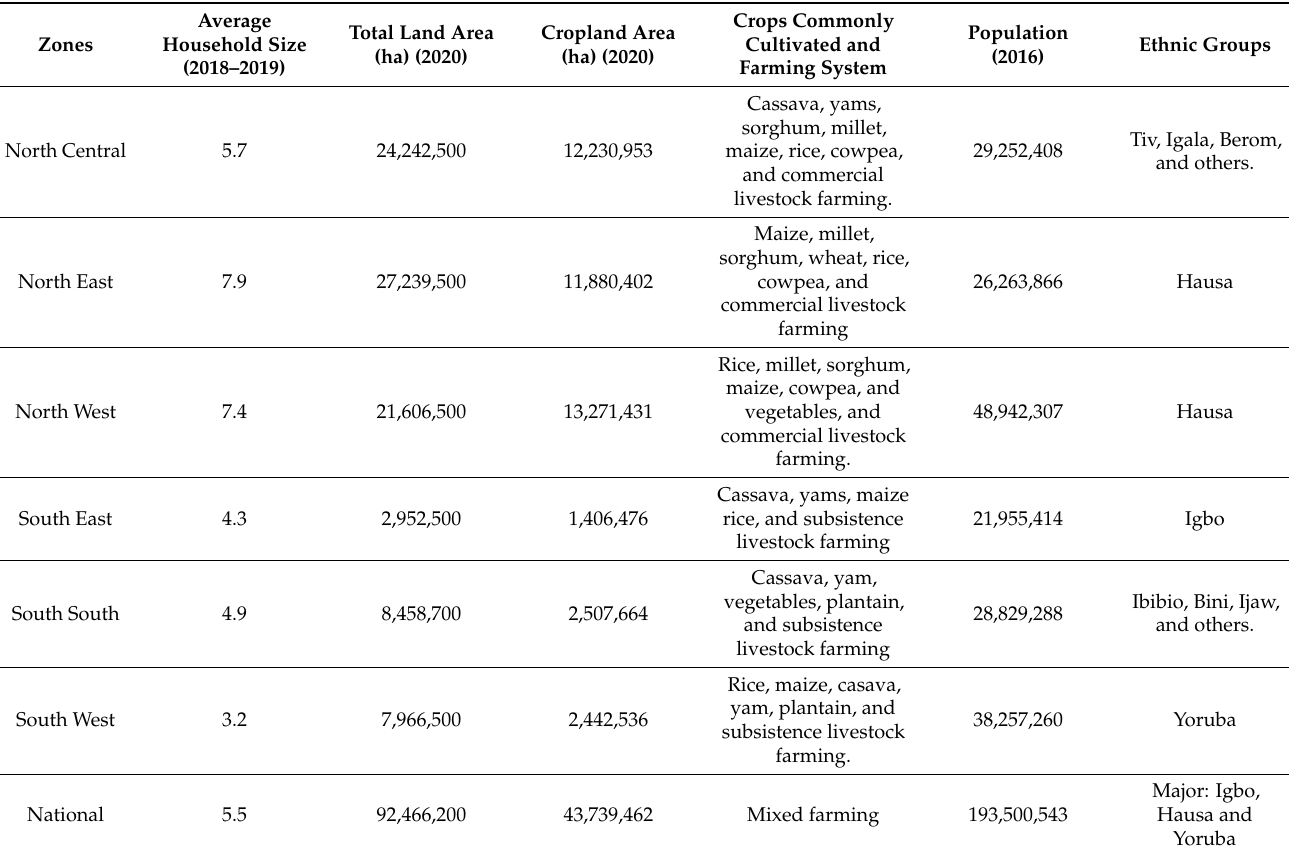
Table 1. The six geopolitical zones’ information at a